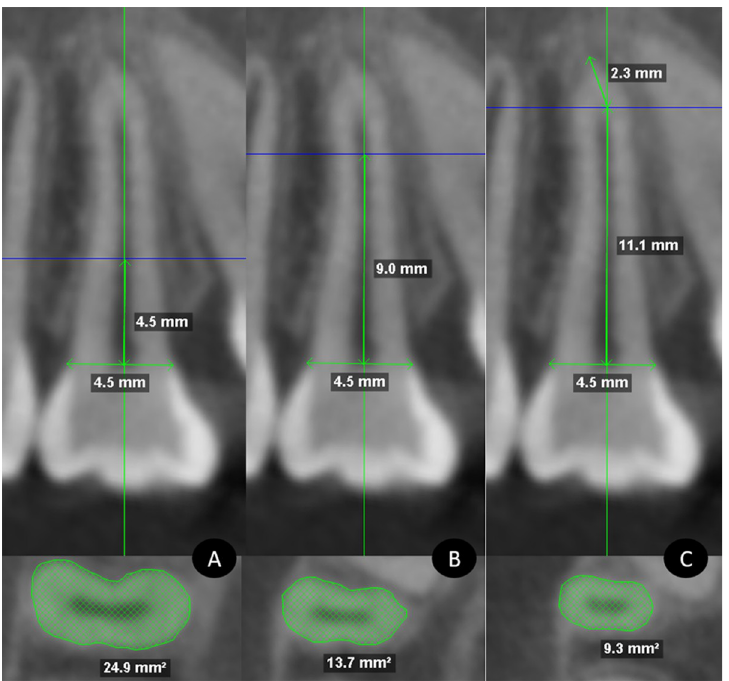
Fig 5. Axial section measurements. A, cervical third. B, middle third. C, region of origin of the